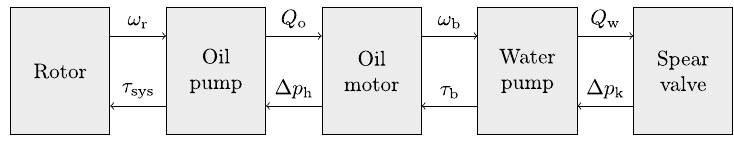
Figure 7. Flow diagram of the DOT500 hydraulic drivetrain. For steady-state modeling purposes, first the flow path is calculated up to the spear valve. The effective nozzle area and the water flow through the spear valve determine the hydraulic feed line pressure, which influences the system torque τ sys to the rotor.